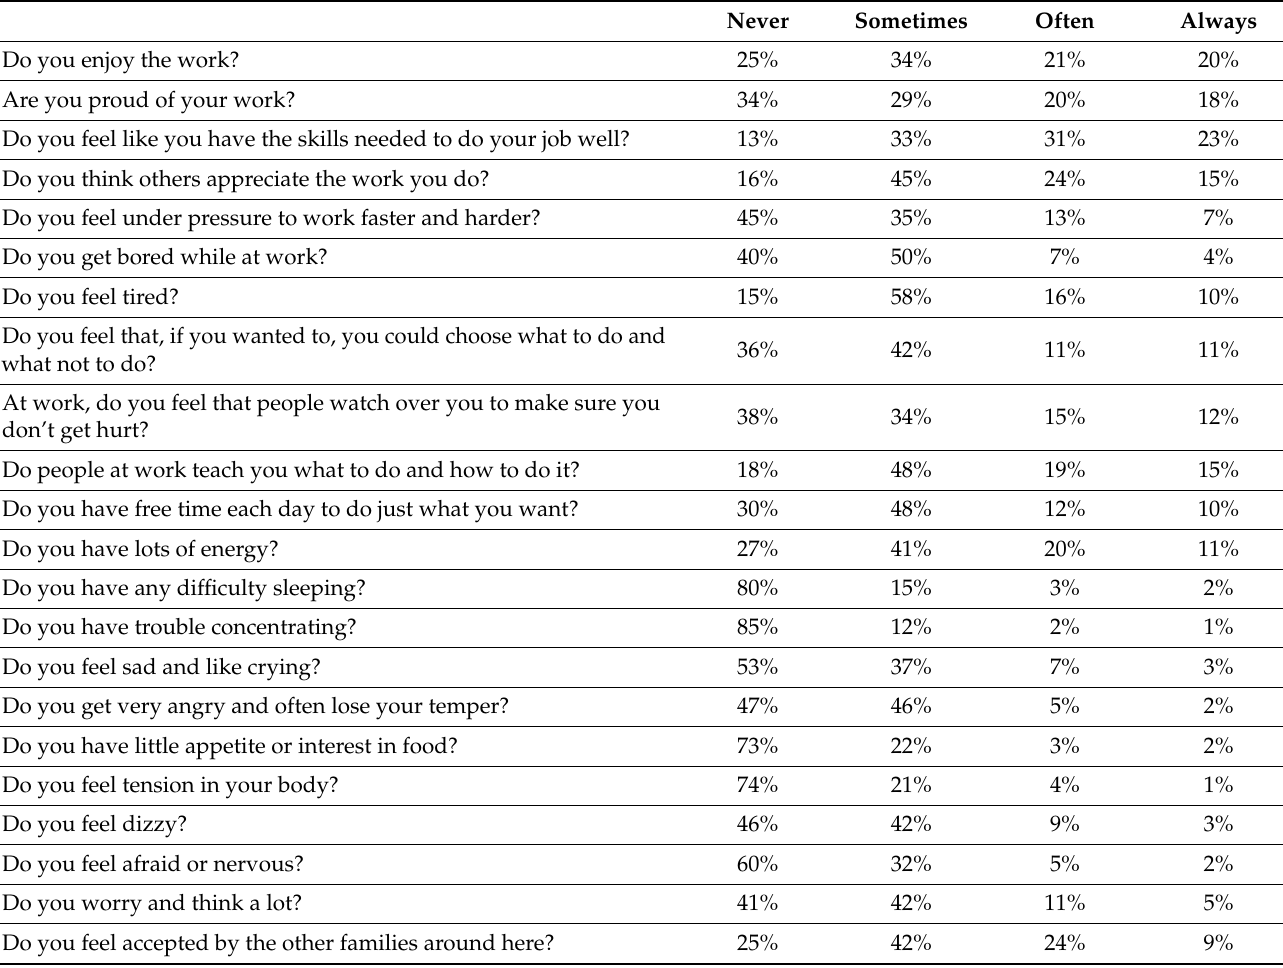
Table A1. Distribution of answers for each item selected.